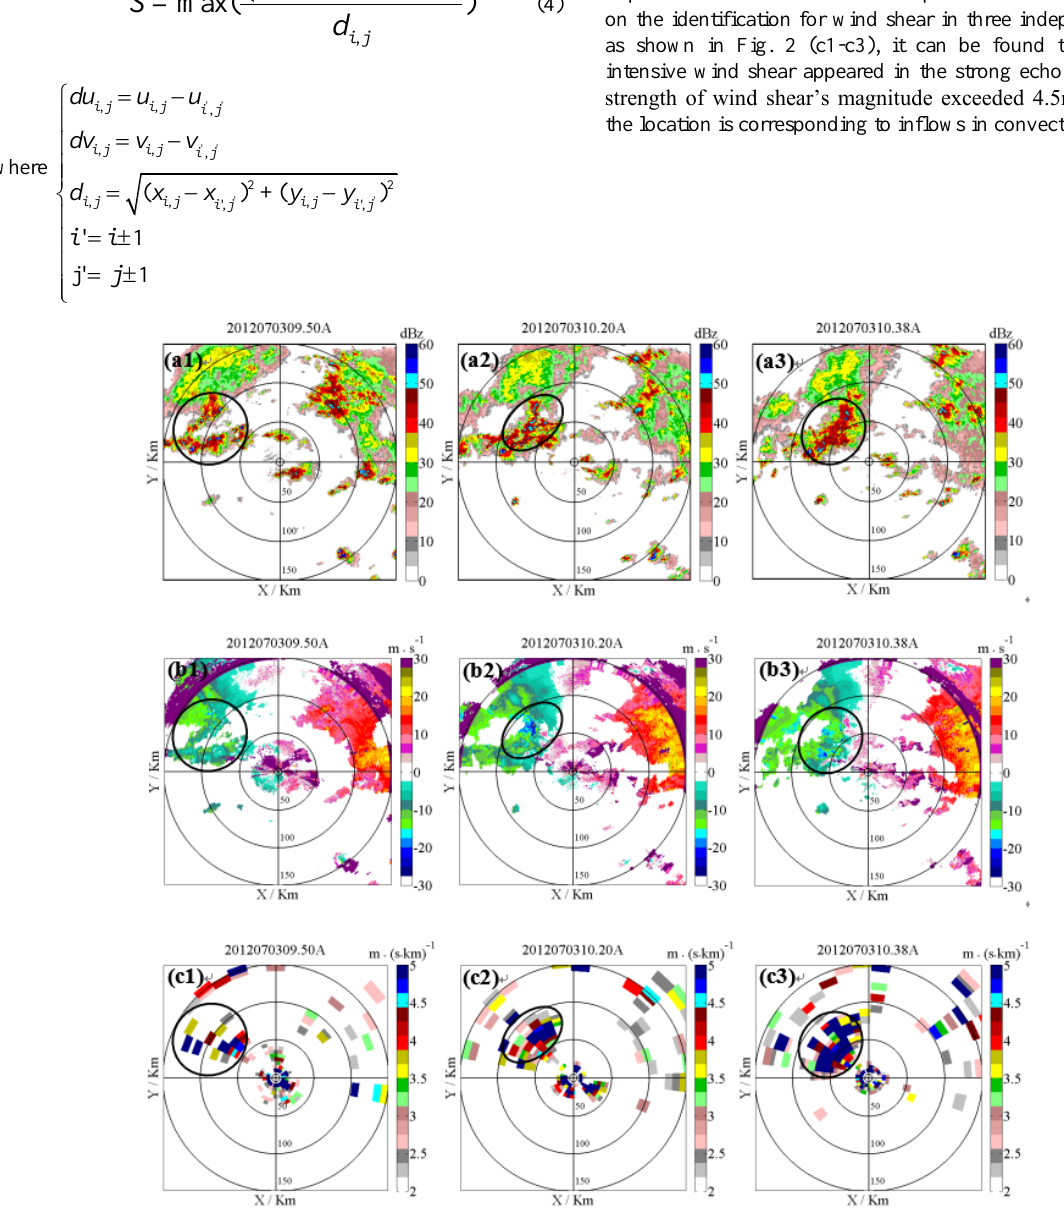
Fig2. The reflectivity factor (a1-a3), radial velocity (b1-b3) and the wind shear (c1–c3) at 17:50, 18:20 and 18:38, July 3, 2012, respectively. (Elevation: 1.5 o